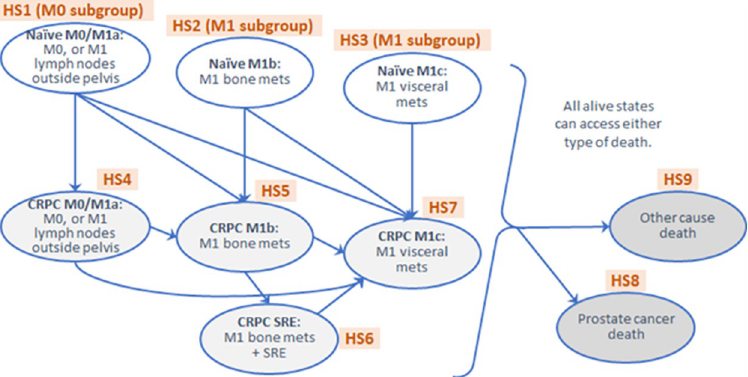
Fig 1. Model structure. Nine health states with 25 allowed transitions (11 arrows among HS1-HS7, plus 1 transition from each alive health state (HS1-7) to each dead health state (HS8-9)).